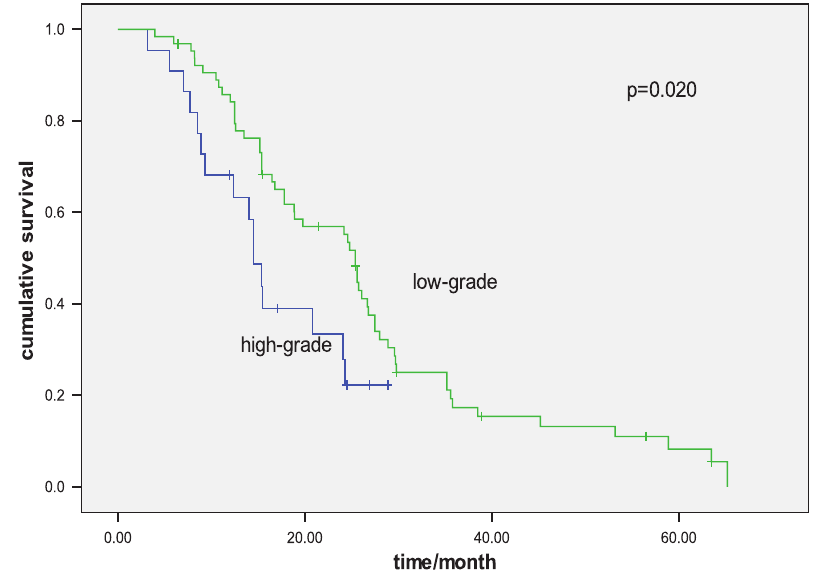
Figure 3 - Kaplan–Meier curves comparing OS in patients with different histological grades. Table 4 - Multivariate survival analysis for disease-Free survival and overall survival.